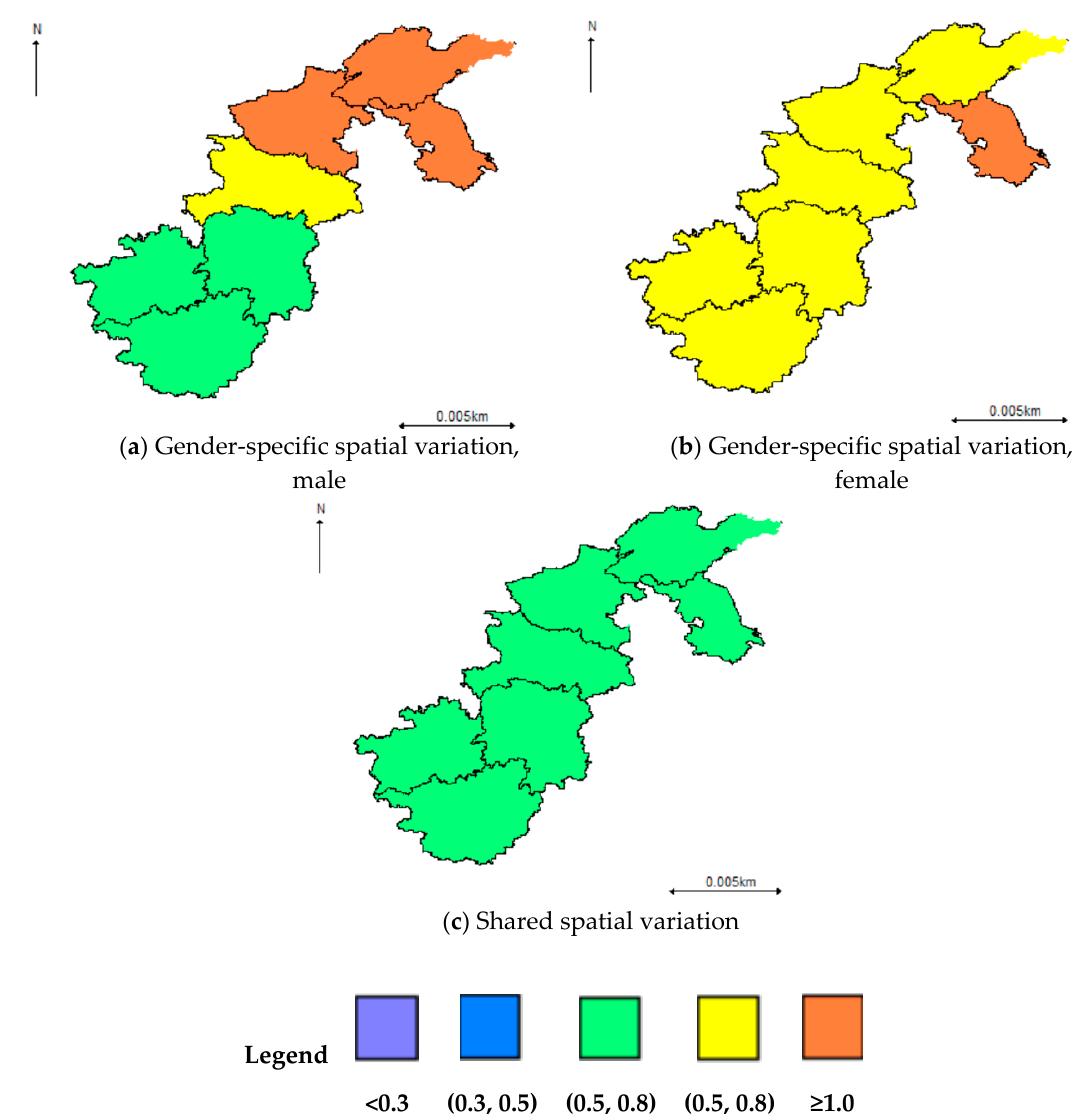
Figure 7. Overall shared and gender-specific variation derived from the spatio-temporal SCM model.